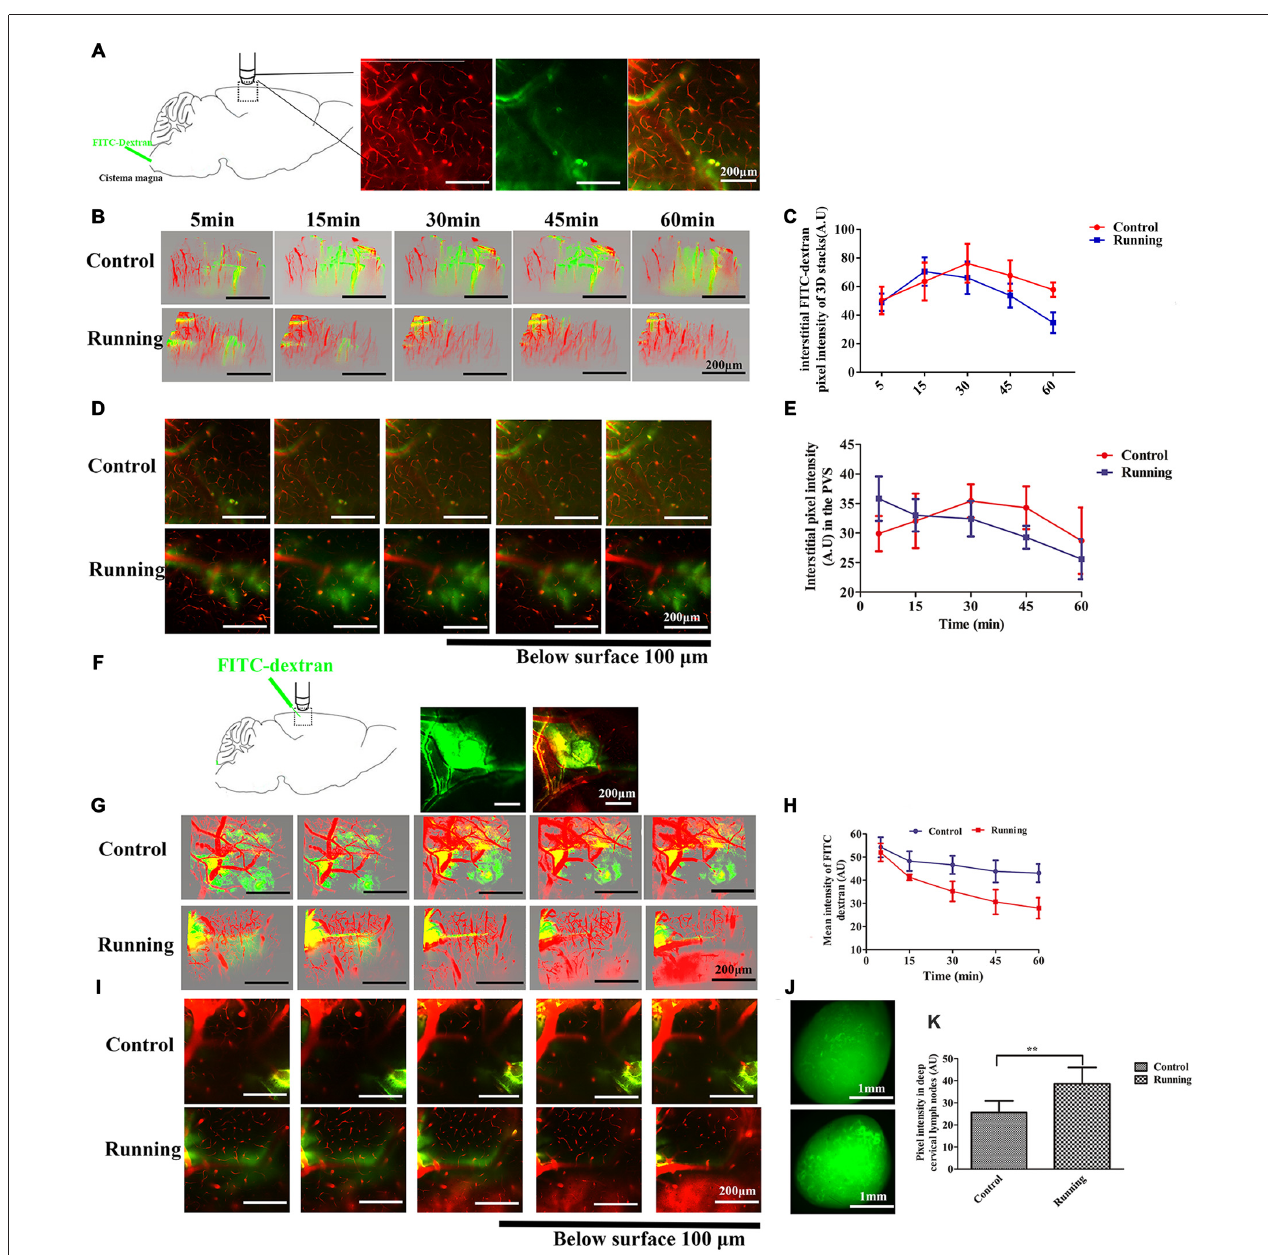
FIGURE 2 | Analysis of two-photon microscopy data on glymphatic clearance, including the influx through paravascular space (PVS)–interstitial fluid (ISF) exchange and the efflux through ISF drainage. (A) Schema showing the infusion of the fluorescein isothiocyanate (FITC)-dextran tracer into the cisterna magna for in vivo two-photon imaging (250 × , scale bar = 200 µ m). (B) Three-dimensional (3D) images of the brain vasculature and the distribution of the cerebrospinal fluid (CSF) tracer at different time points in the control and running groups (250 × , scale bar = 200 µ m). (C) Quantitative analysis of the mean pixel intensity of the tracer in the 3D image stacks in (B) , which shows that the influx and clearance of the CSF tracer were markedly accelerated in the running group compared with the control group ( n = 6 per group). (D) Representative image of the CSF tracer along the perivascular spaces penetrating into the brain parenchyma, 100 µ m below the cortical surface (250 × , scale bar = 200 µ m). (E) Quantitative analysis of the fluorescence intensity of the CSF tracer in the PVS shown in (D) ( n = 6 per group). (F) Schema showing the dissipation of the FITC-dextran tracer in the brain parenchyma during in vivo two-photon imaging, which indicates the efflux of the glymphatic system (100 × , scale bar = 200 µ m). (G) Representative 3D images of dye alignment at different time points in the control and running groups (250 × , scale bar = 200 µ m). (H) Comparison of the average fluorescence intensity in the parenchyma of the control and running groups at different time points ( n = 6 per group). (I) Representative image of the dye alignment along the PVS, 100 µ m below the cortical surface (250 × , scale bar = 200 µ m). (J) Representative image of the ISF drainage into the deep cervical lymph nodes in the control and running groups at 1 h after FITC-dextran was injected into the brain parenchyma (50 × , scale bar = 1 mm). (K) Comparison of the average fluorescence intensity in the deep cervical lymph nodes of the control and running groups ( n = 6 per group). Datasets are expressed as means ± SD, n = 6. ∗∗ P ≤ 0.01.